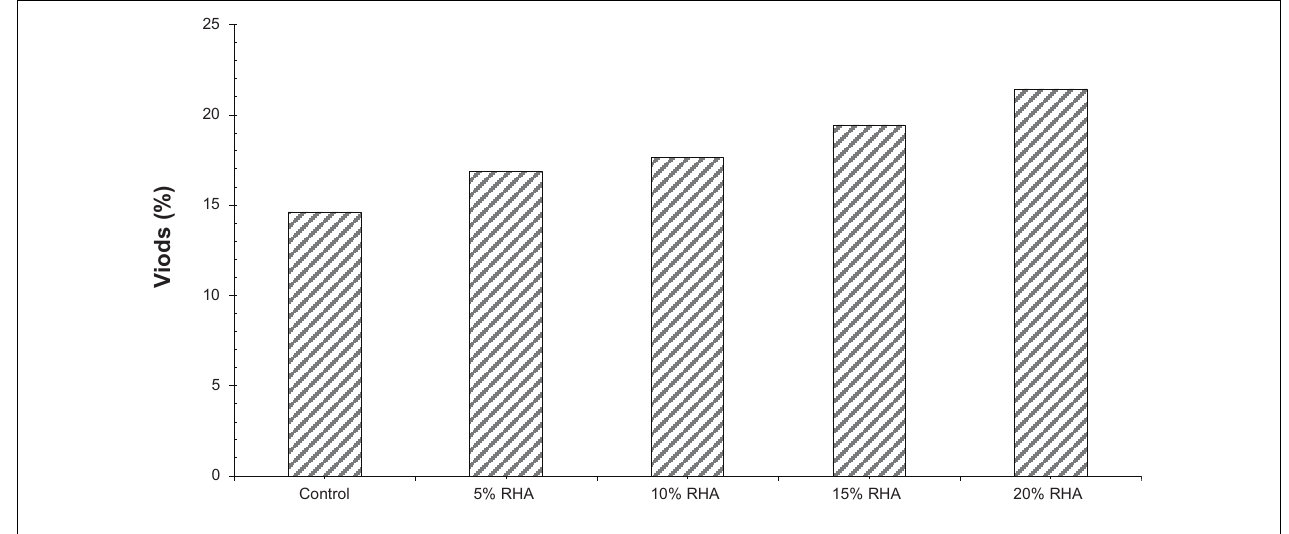
FIGURE 14 | Voids Volume (without steel fibers and superplasticizer).